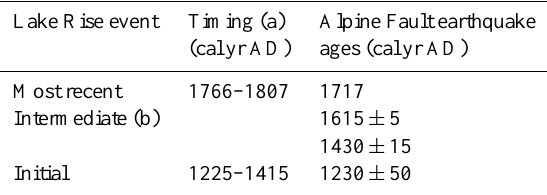
Table 3. Relationship between the preferred timing of lake rise events in Lake Poerua and Alpine Fault earthquake